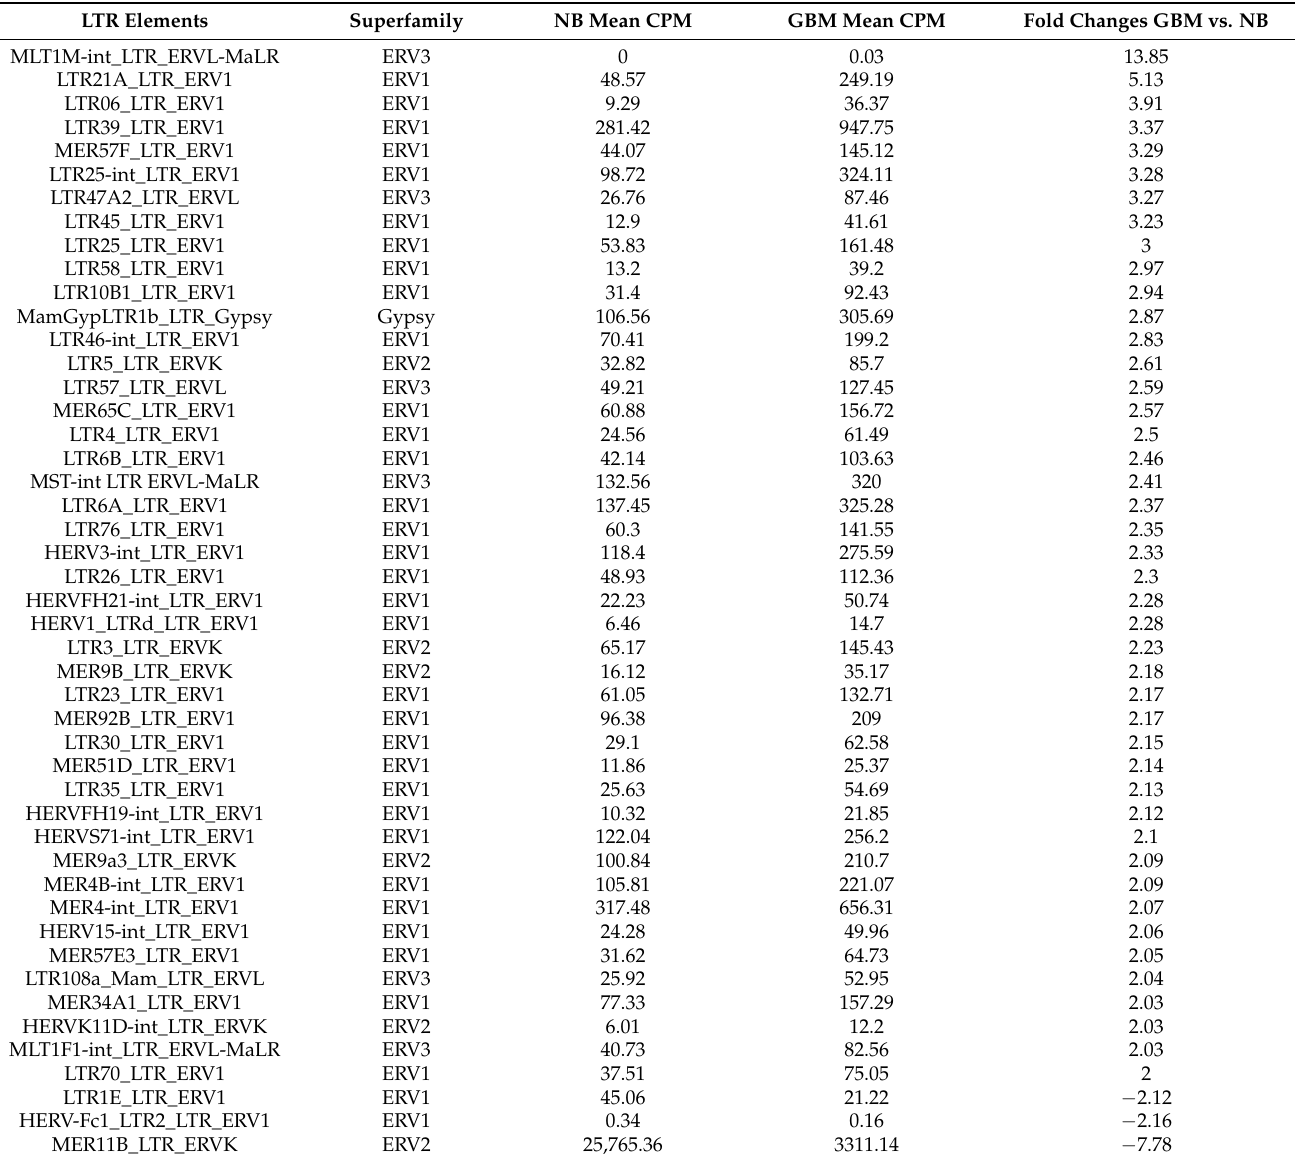
Table 1. LTR elements that are significantly differentially expressed ( p -value < 0.05 and |fold change| ≥ 2) in glioblastoma multiforme (GBM) tissues, cell cultures, and normal brain (NB). The superfamily, CPM (counts per million), and fold change of the differentially expressed LTR elements in GBM and normal brain samples are